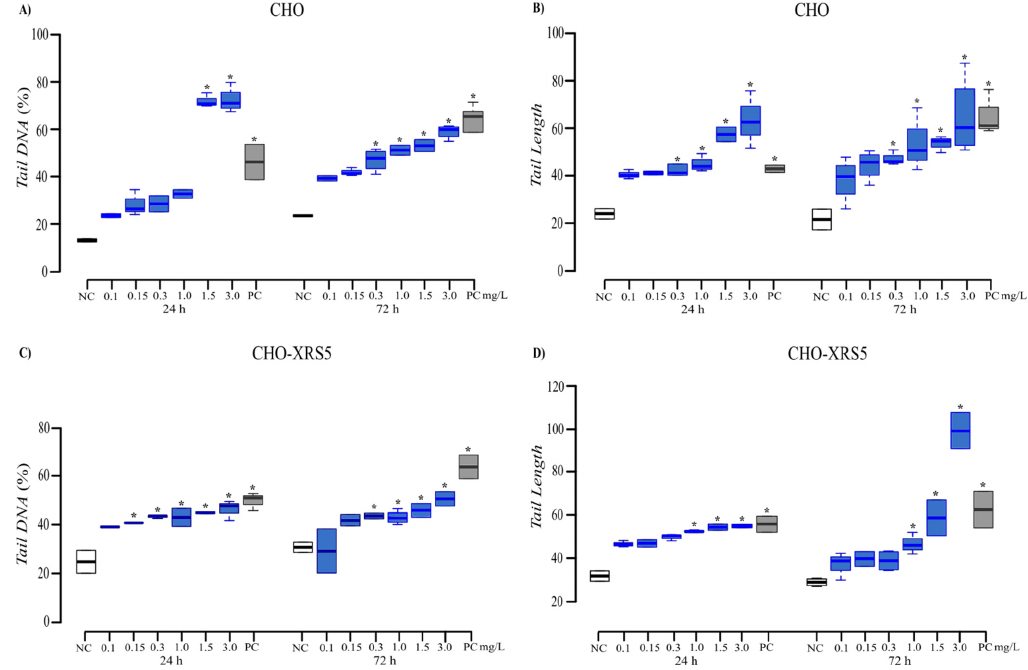
Figure 5. Tail DNA ( A , C ) and Tail Length ( B , D ) measured in CHO ( A , B ) and CHO-XRS5 ( C , D ) cells exposed to manganese (blue) for 24 and 72 h. The values are expressed as medians and interquartile deviations of two independent experiments. * p < 0.05 compared to the negative control by the Kruskal–Wallis test followed by Dunn’s test. NC, negative control (white); PC, positive control (mitomycin C;